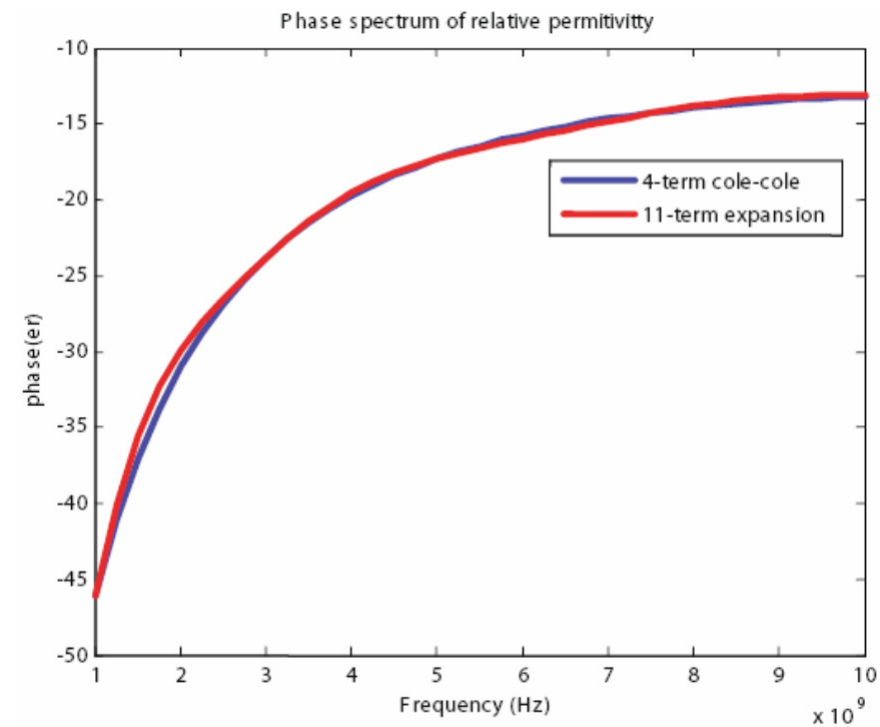
Figure 13. Phase spectrum of the relative permittivity for the 4 term Cole-Cole model and the spectrum approximation.